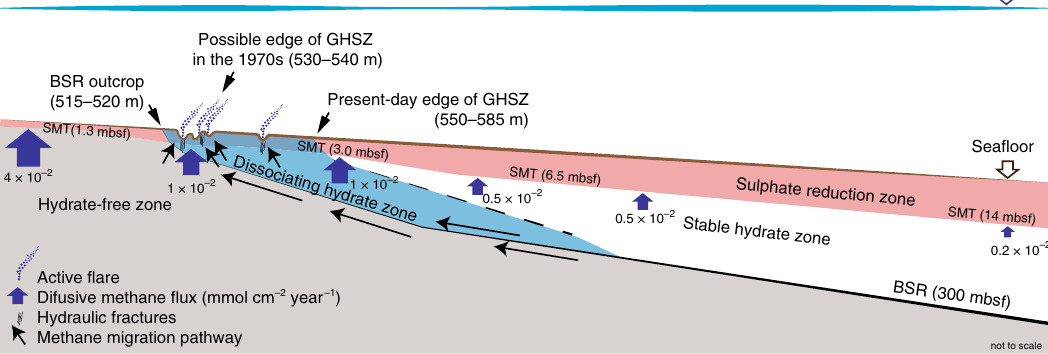
Fig. 6 Section across the edge of the hydrate stability zone. Schematic section across the upper slope of the Rio Grande cone, showing the location of active gas fl ares, together with estimates of methane diffusive fl ux (mmol cm − 2 yr − 1 ). Blue arrows indicate possible methane migration pathways in the hydrate-free, dissociating hydrate, and stable hydrate zones. Note the diminishing diffusive methane fl ux and deepening of the sulfate − methane transition (SMT) downslope towards a thickening gas hydrate stability zone (GHSZ) indicated by the bottom simulating re fl ector